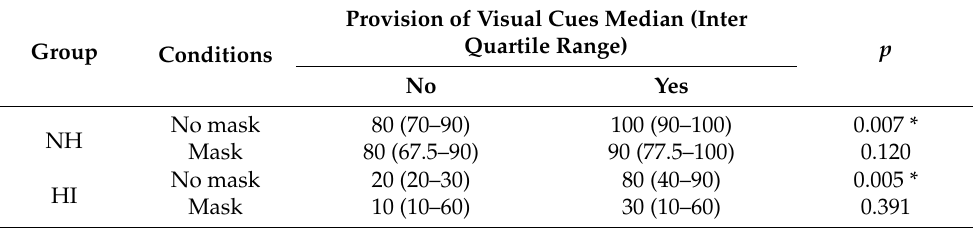
Table 1. Statistical analysis of the groups’ speech performance in the no visual cues and visual cues conditions (* p < 0.05).